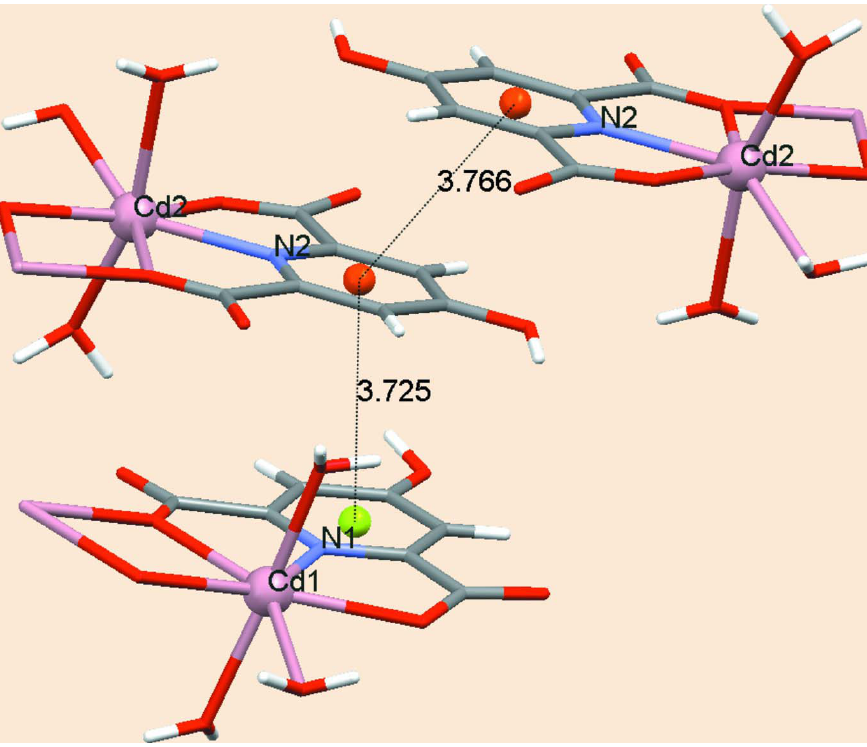
Figure 3 π – π Stacking interactions of Cg 1– Cg 2 ( Cg 1: N1/C1–C5; Cg 2: N2/C8–C12) and Cg 2– Cg 2 of the title compound. The average distances between the planes are 3.725 (3) Å ( x , 1 + y , z ) and 3.766 (3) Å (1 - x , - y , - z ),